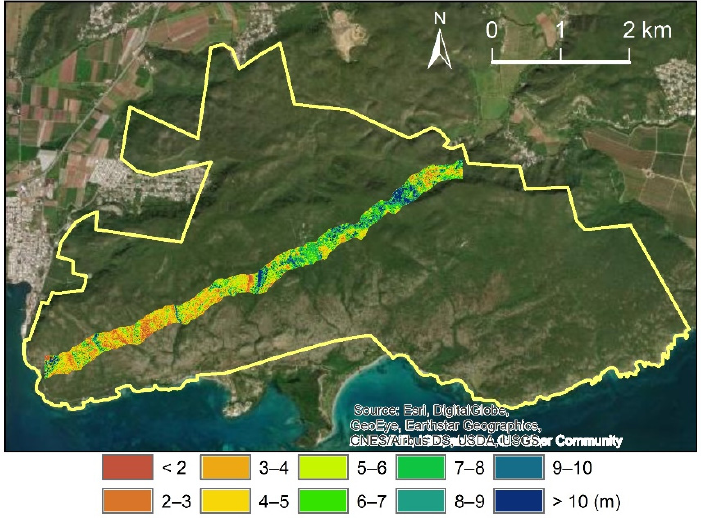
Figure 2. Location of the transect of “PR_8March2017_45_46” flew by the NASA G-LiHT, about 7 km long and 280 m wide. The greenness indicates the canopy height measured before the hurri- canes.